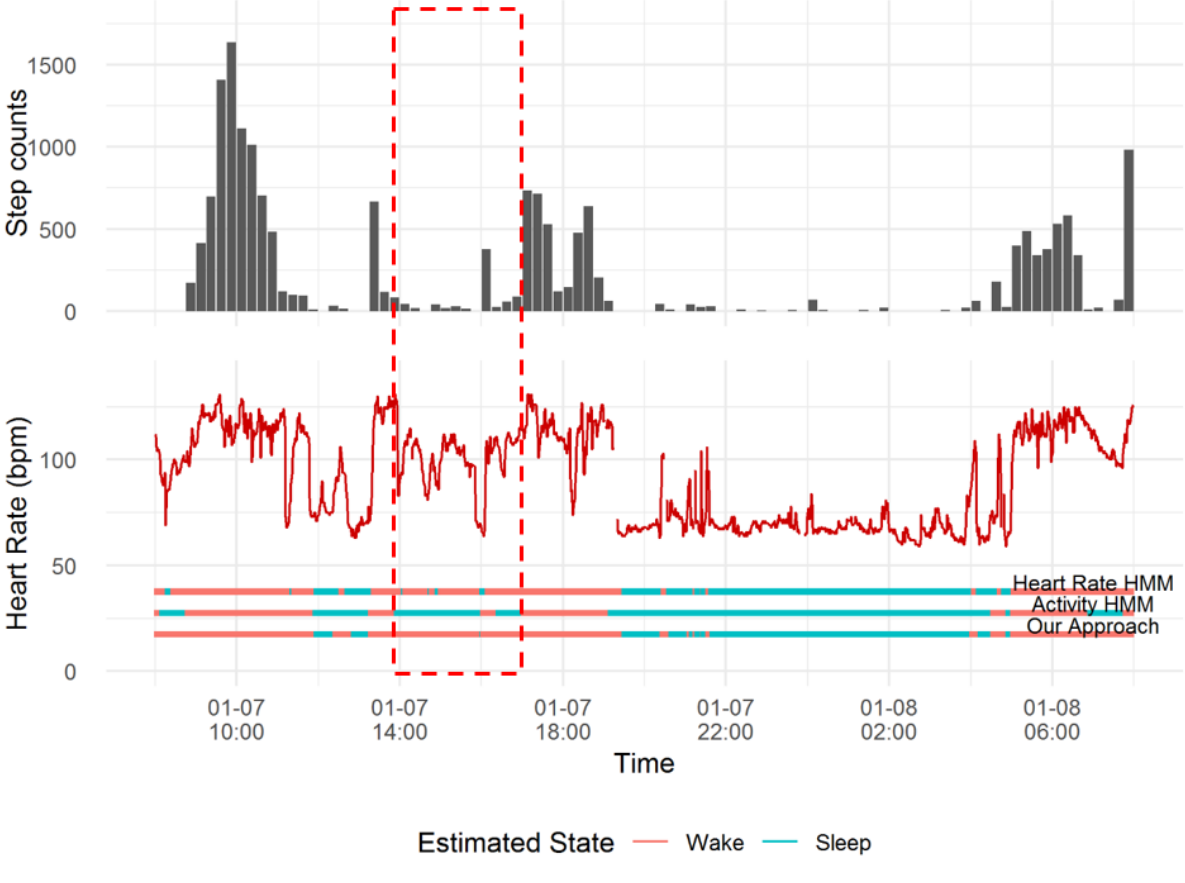
Figure 6. An example plot of observations and scoring results from Heart Rate HMM, Activity HMM, and our approach for EL02. HMM: hidden Markov